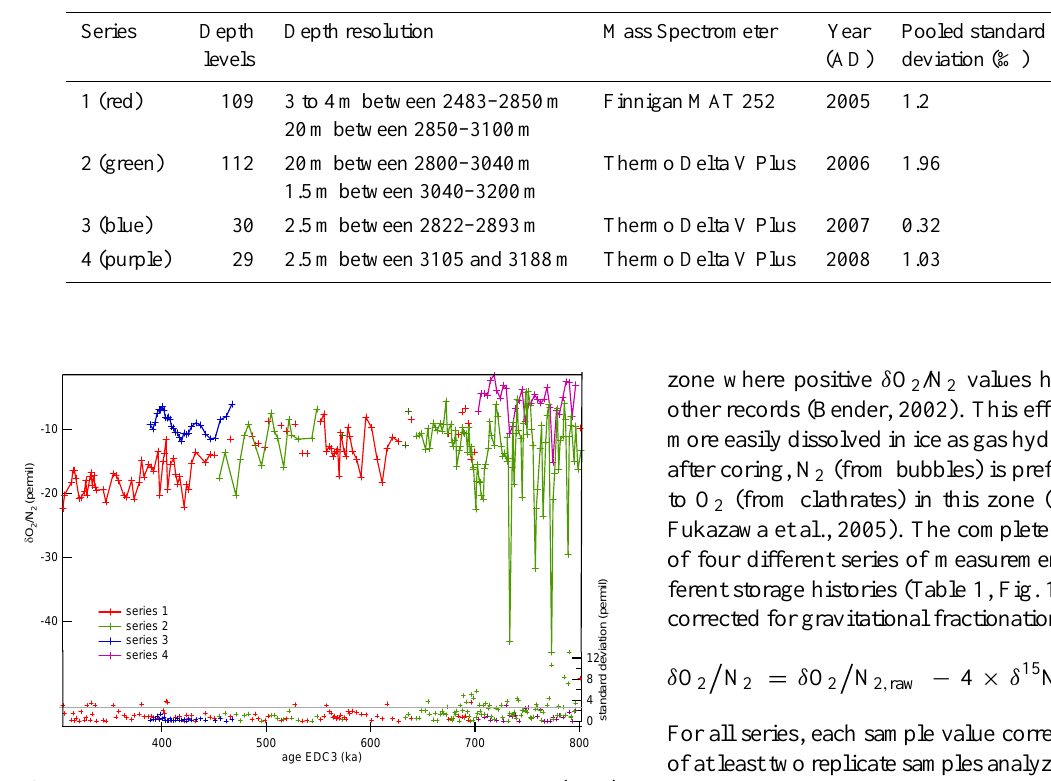
Fig. 1. Measurements of δ O 2 /N 2 in the EPICA Dome C (EDC) ice core plotted on the EDC3 ice core age scale (Parrenin et al., 2007) and associated uncertainty (1 σ , bottom panel). The EDC δ O 2 /N 2 record is composed of four distinct measurement series (top panel). Samples measured in Series 1 and 2 were stored at − 25 ◦ C whereas samples measured in Series 3 and 4 were stored at − 50 ◦ C. Characteristics of the different series are given in Table 1: Series 1 in red, Series 2 in green, Series 3 in blue, Series 4 in